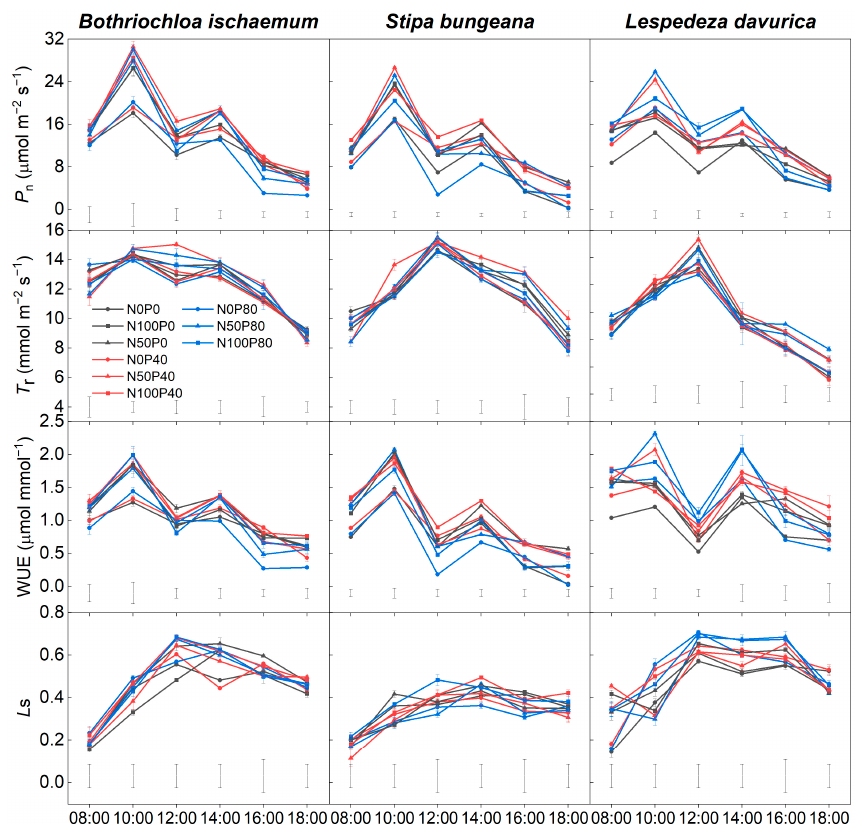
Figure 2. Diurnal changes of net photosynthetic rate ( P n ), transpiration rate ( T r ), instantaneous water use efficiency (WUE), and stomatal limitation value ( L s ) of the three species under different N and P addition treatments. Vertical bars indicate LSD values.